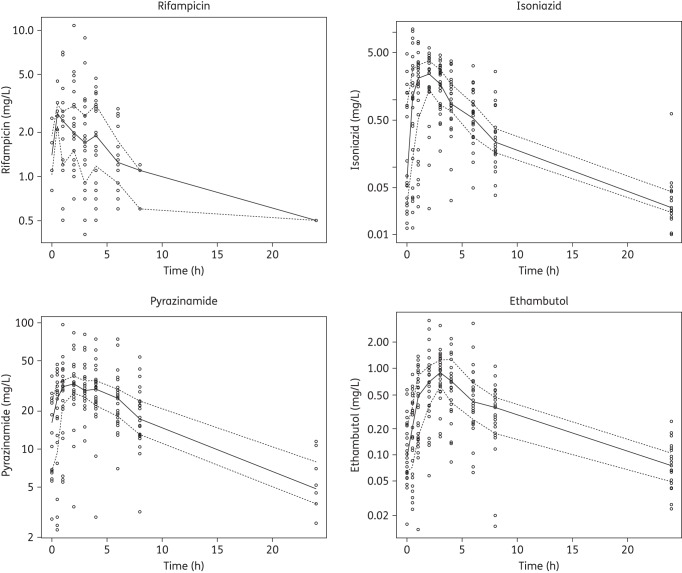
Summary semi-logarithmic scatterplots of plasma concentrations of anti-TB drugs. Continuous lines represent median concentrations and broken lines represent upper and lower quartiles.